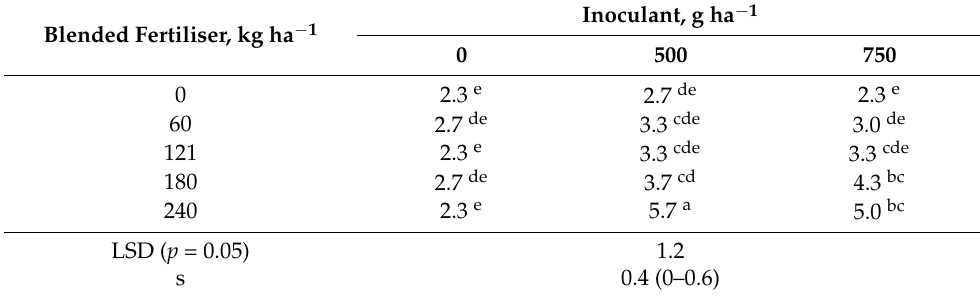
Inoculant, g ha − 1